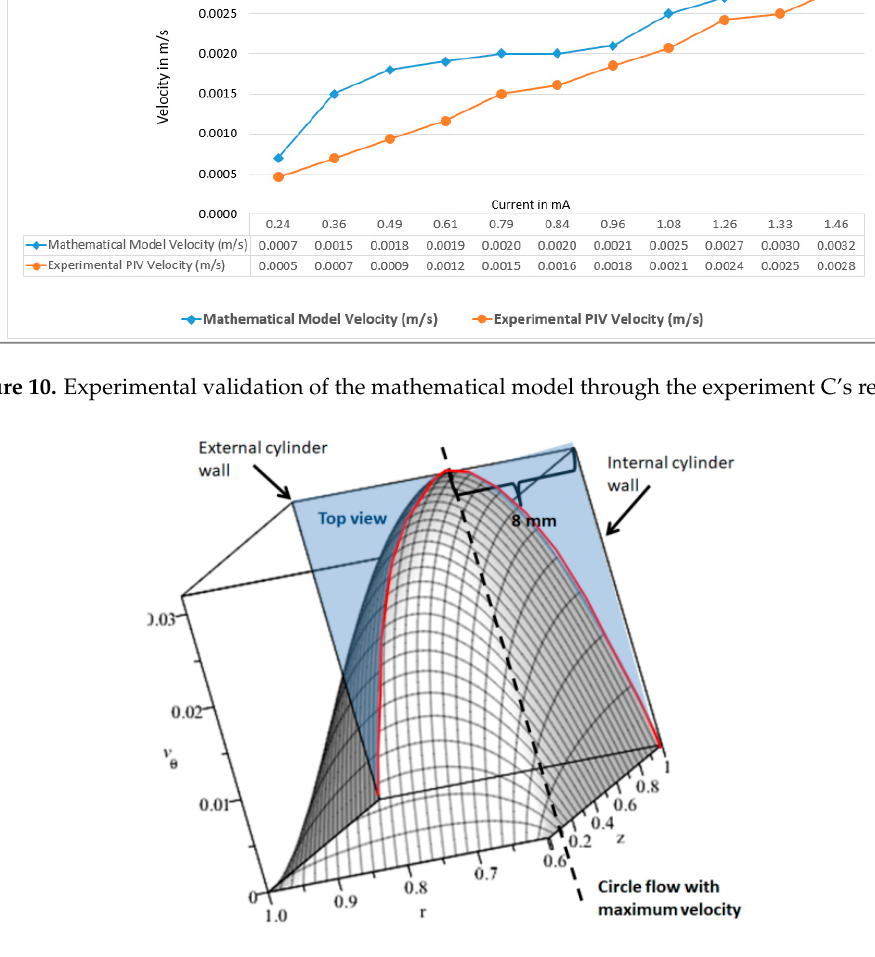
Figure 11. 3D Mathematical model velocity profile for experiment C.